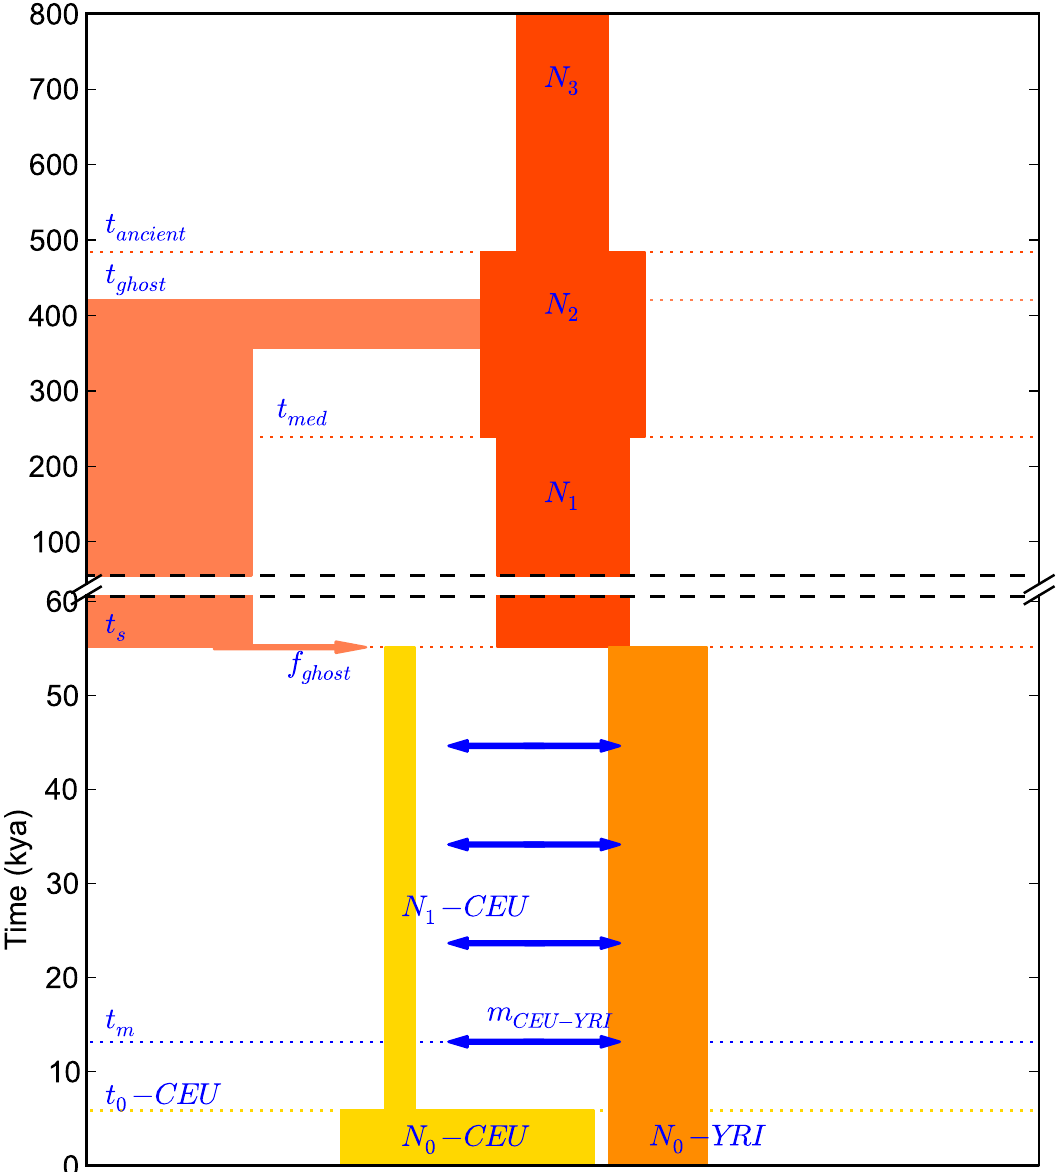
Figure 7. A history inferred from IBS sharing in Europeans and Yorubans. This is the simplest history we found to satisfactorily explain IBS tract sharing in the 1000 Genomes trio data. It includes ancient ancestral population size changes, an out-of-African bottleneck in Europeans, ghost admixture into Europe from an ancestral hominid, and a long period of gene flow between the diverging populations.